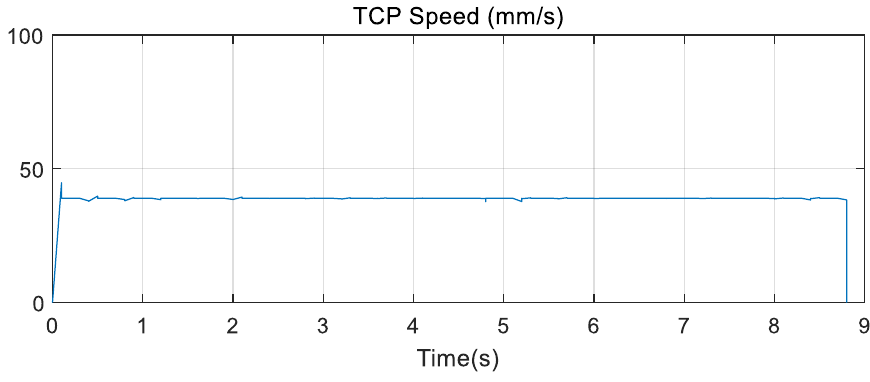
Figure 16. Scanned points and path mapped out using 169 points.